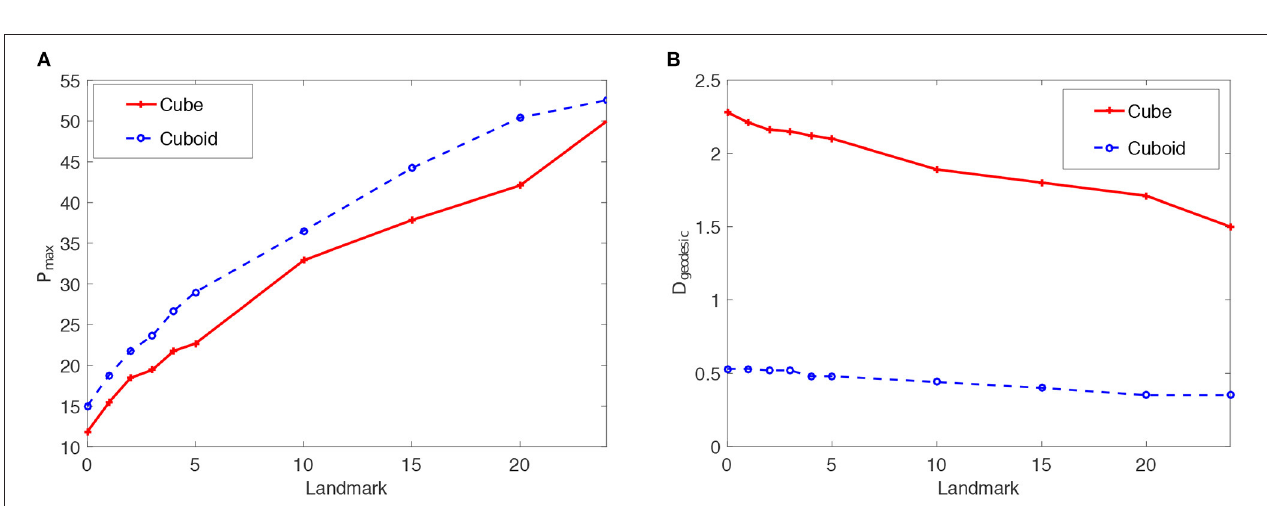
FIGURE 4 | Statistics means of the reconstruction accuracy P max and the geodesic distance D geodesic for the proposed articulated tactile learning model and the unarticulated model when representing a 2 models when representing such two 3D